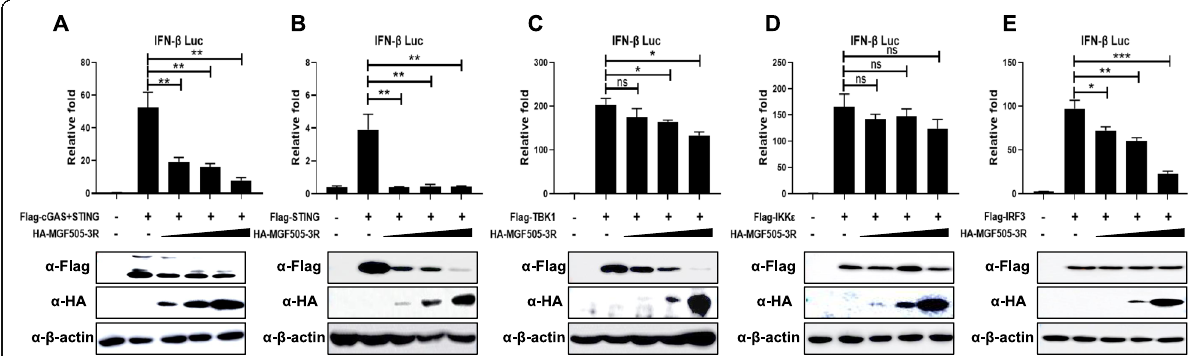
Fig. 3 MGF505-3R inhibited IFN- β activity through multiple sites. A-E HEK293T cells were cultured overnight in 24-well plates, and increasing doses of HA-MGF505-3R plasmid (50 ng, 100 ng, 200 ng) were cotransfected with the IFN- β -Luc plasmid (100 ng), pRL-TK plasmid (50 ng) and signaling molecule plasmids (Flag-cGAS, Flag-STING, Flag-TBK1, Flag-IKK ε , Flag-IRF3) (200 ng) for 24 h. “ + ” represents transfected, “ - ” represents nontransfected. For all cell lysates, the target proteins were detected by dual-luciferase reporter assays and western blotting. Quantitative analysis of protein blots was performed using ImageJ software. All data from 3 independent experiments are expressed as the mean ± SD. * P <0.05, ** P <0.01, *** P <0.001